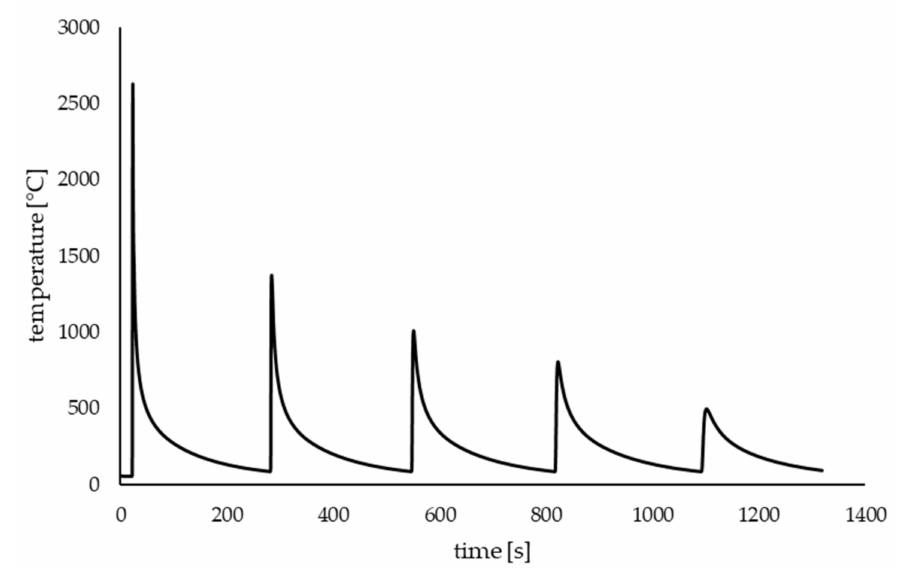
Figure 13. Time–temperature cycle for point x in the welding simulation for wall structure (length 300 mm) and energy input per unit length 4 kJ/cm with layer 25.